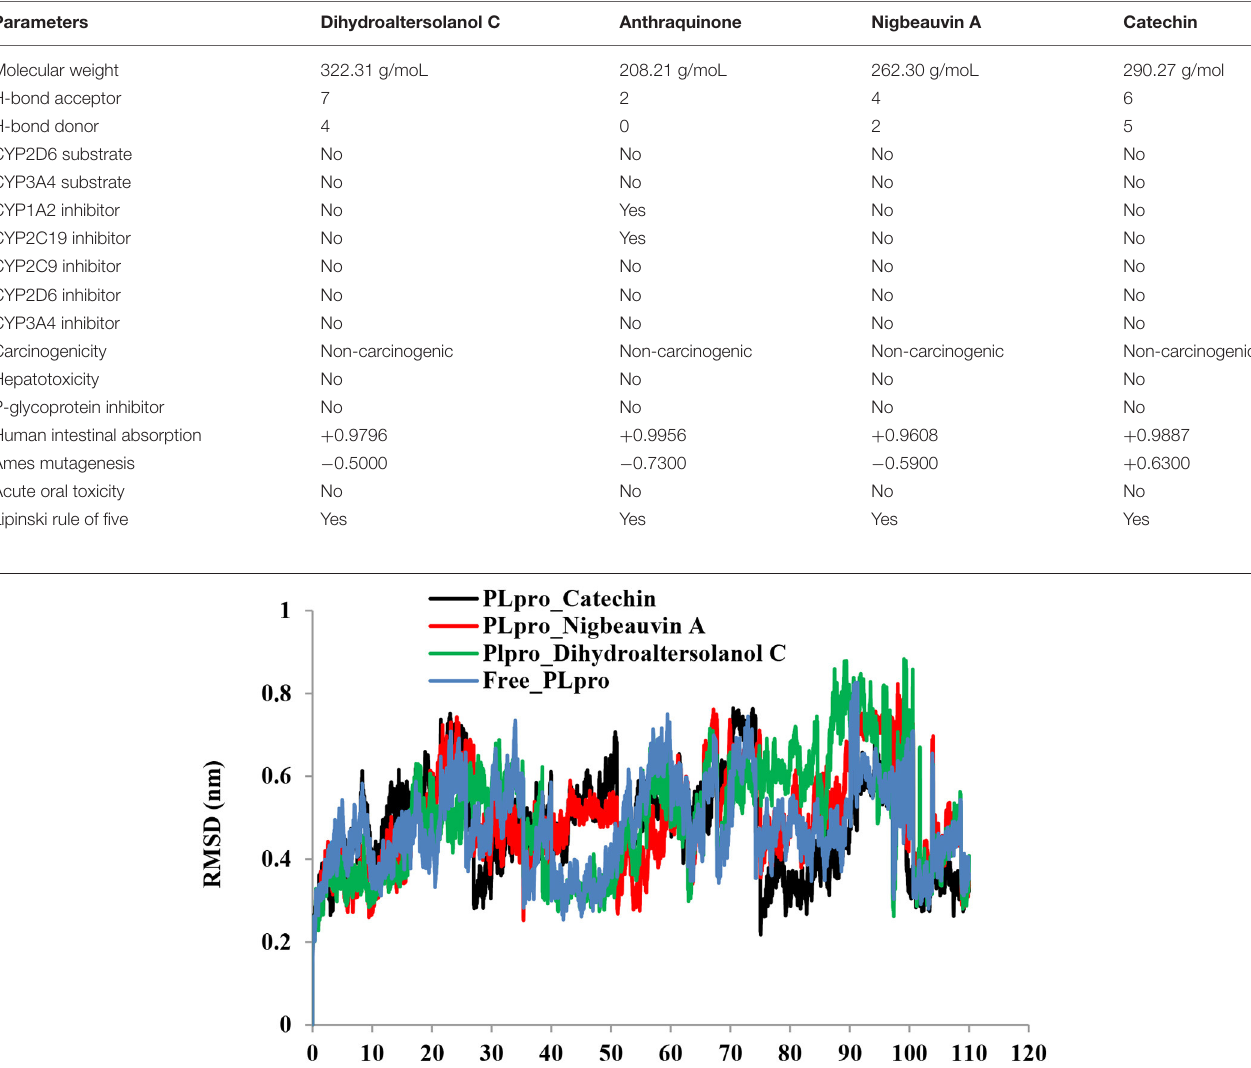
TABLE 2 | Pharmacokinetic and Toxicity Properties for the top four bioactive fungi-derived molecules, which were derived from the SwissADME, admetSAR, and pKCSM webservers. Parameters